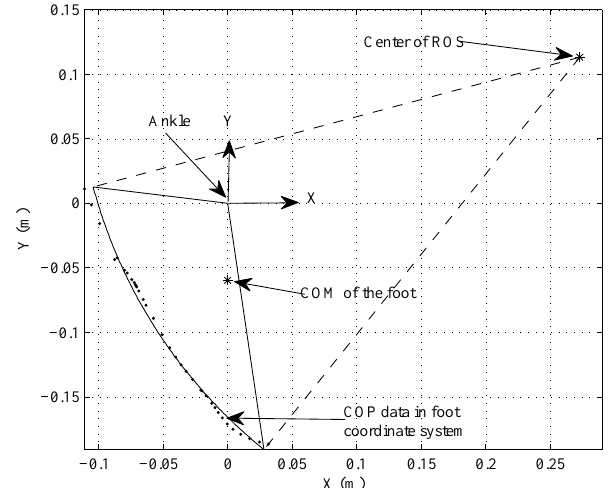
Figure 3. AFROS with y axis (of the coordinate system fixed to the shank) along the shank